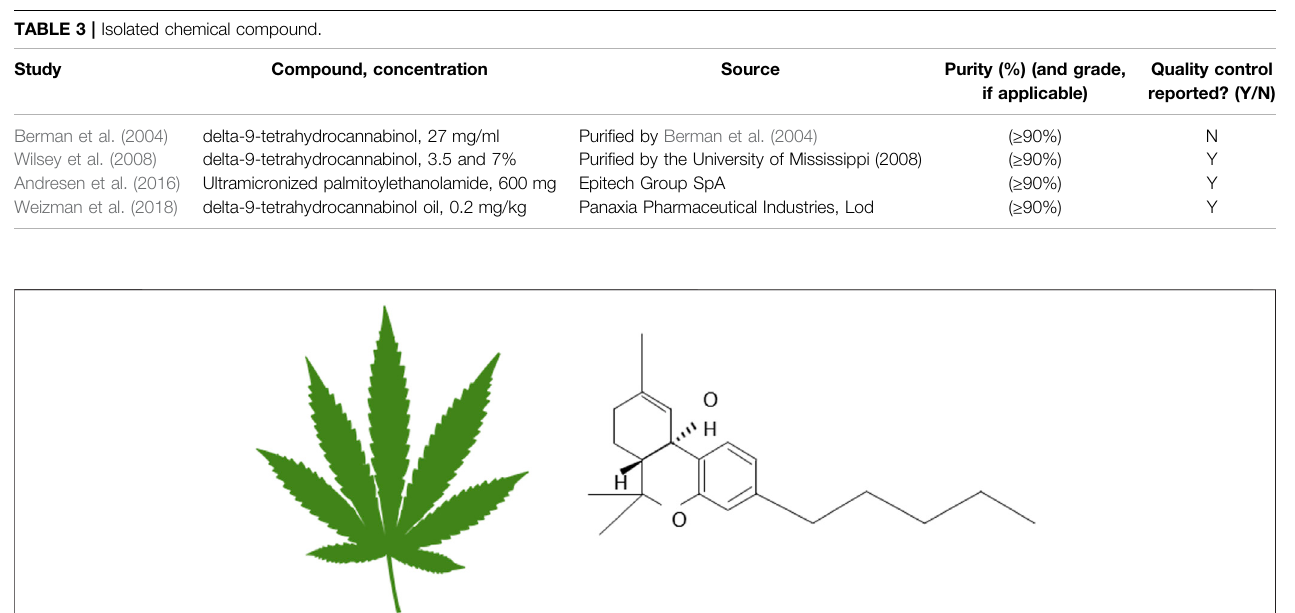
FIGURE 2 | Illustration of cannabinoids and the chemical formula of the main ingredient